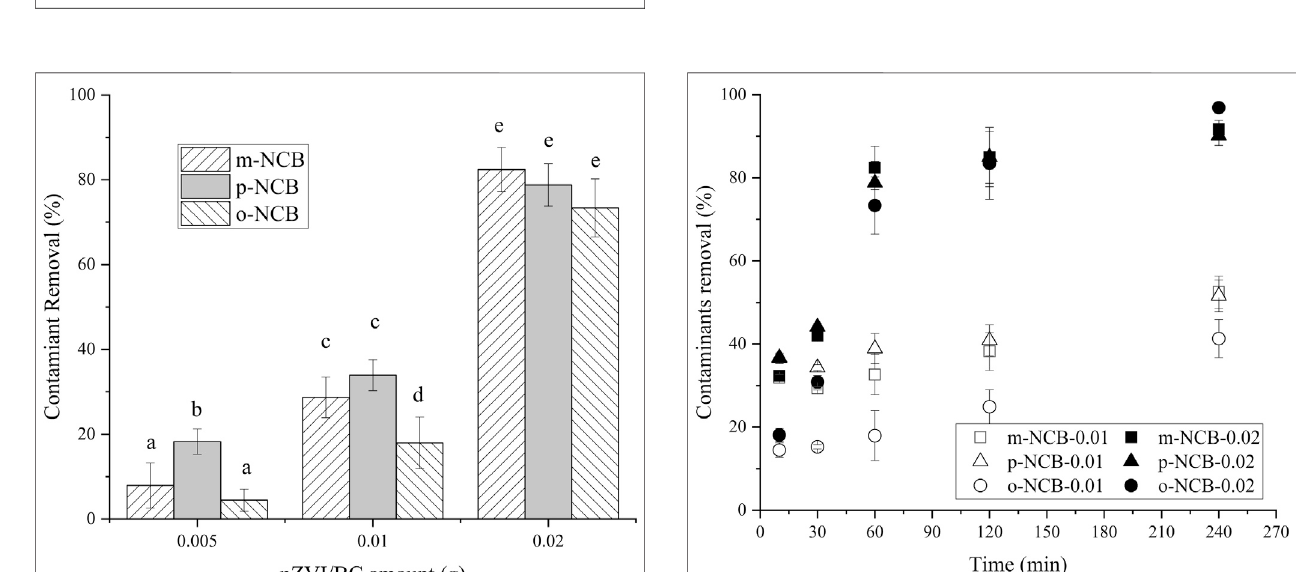
FIGURE 2 | Effect of Fe/C in composite on NCB degradation. The nZVI/ BCamount0.01 g,Fe/PSmolarratio1:1,theinitialNCBisomerconcentration 10 mg L − 1 , and the reaction time 2 h.